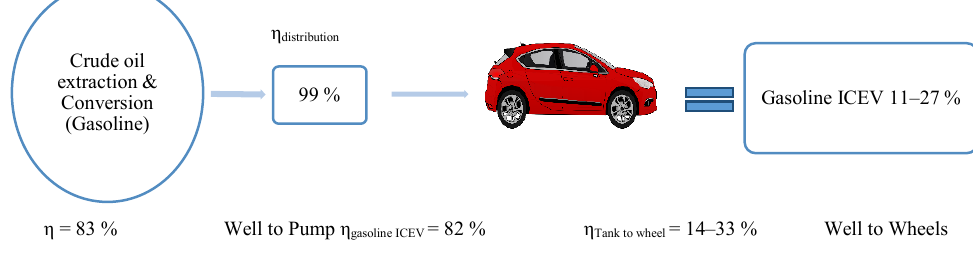
Fig. 1. WTW efficiency of gasoline